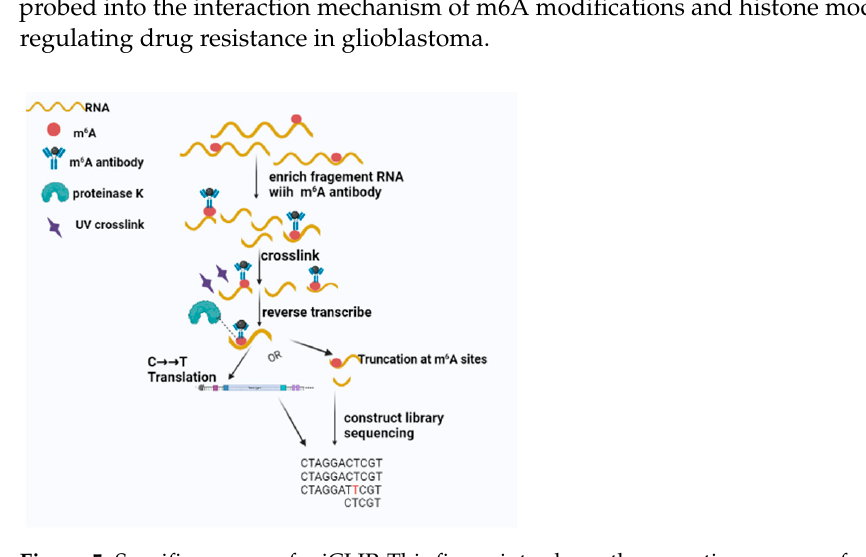
Figure 5. Specific process of miCLIP. This figure introduces the operation process of miCLIP.